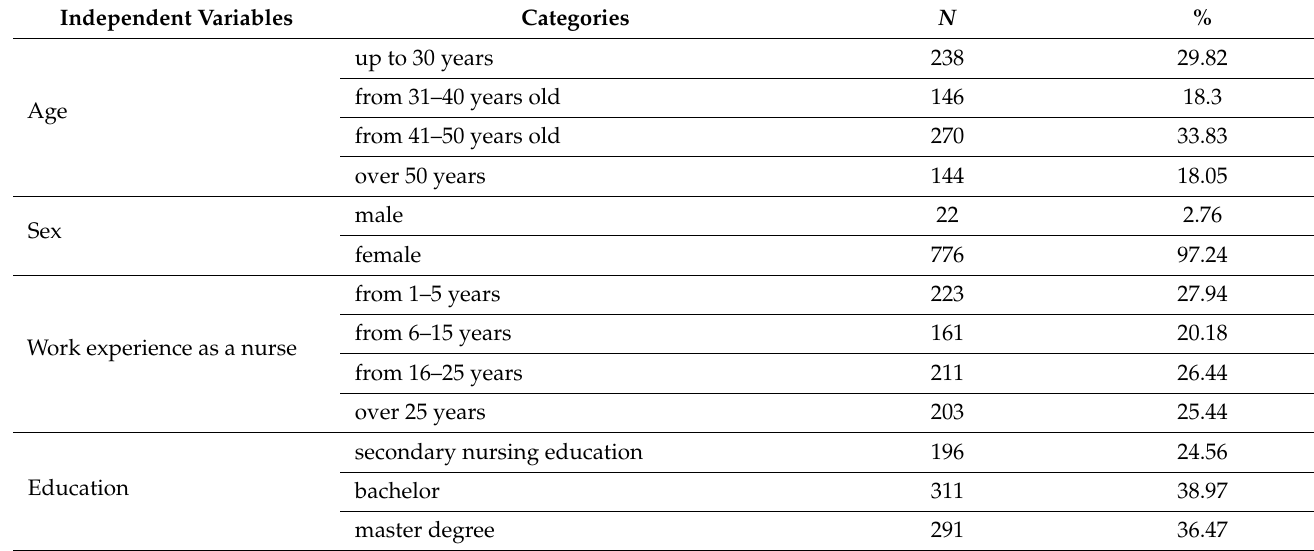
Table 1. Characteristics of the surveyed nurses ( N =